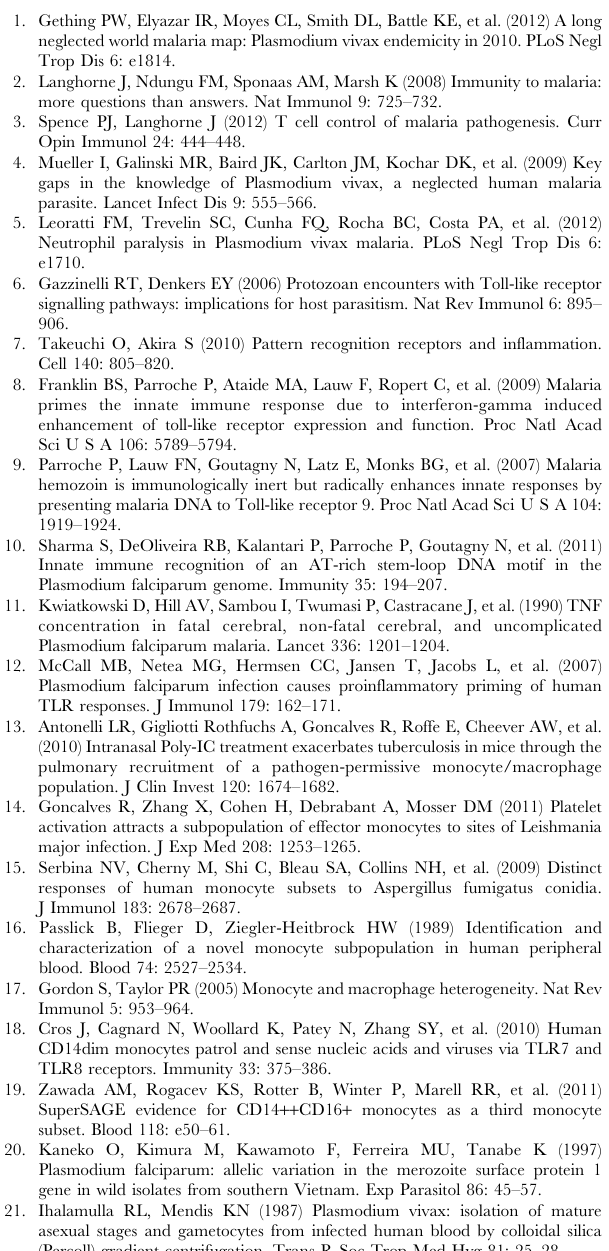
Table S1 Study population. Laboratory and clinical records of Plasmodium vivax -infected patients. Text S1 Supporting methods for apoptosis assay and ROS